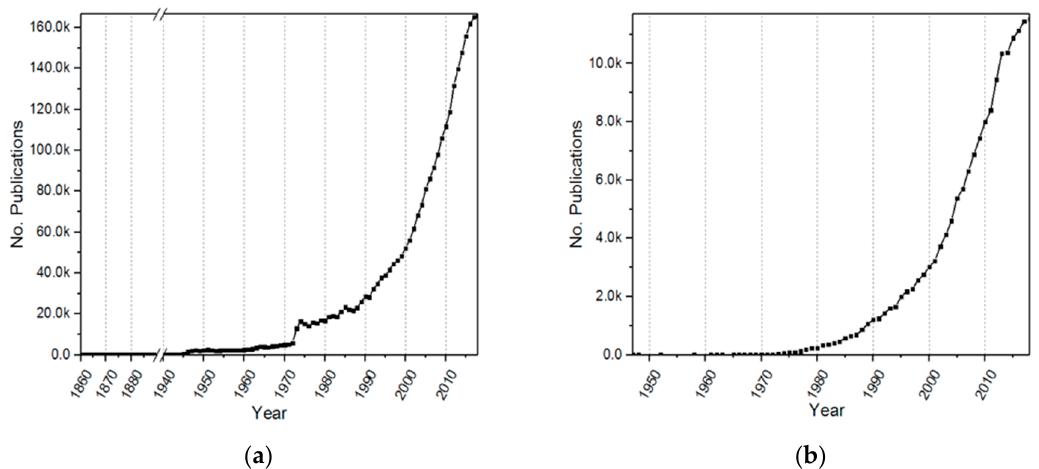
Figure 1. Number of publications of cancer in Scopus; ( a ) total number of cancer-related publications from 1860 to 2018 using the search string “TITLE-ABS-KEY (cancer)”; ( b ) total number of colorectal cancer-related publications from 1947 to 2018 using the search string “TITLE-ABS-KEY (colorectal and